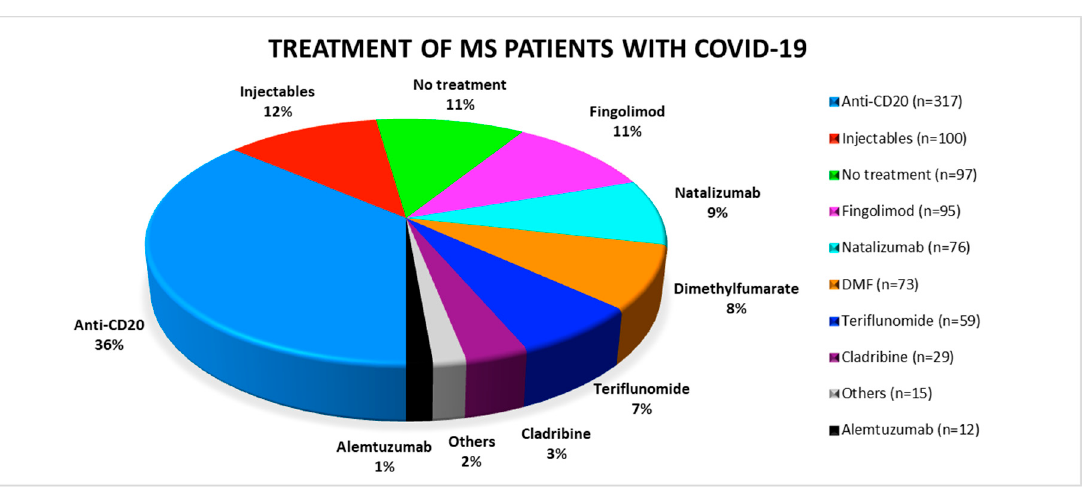
Figure 1. Distribution of the respective disease modifying therapies among the published SARS-CoV-2 positive multiple sclerosis patients. COVID-19: coronavirus disease 2019; DMF: dimethyl-fumarate; MS: multiple sclerosis.